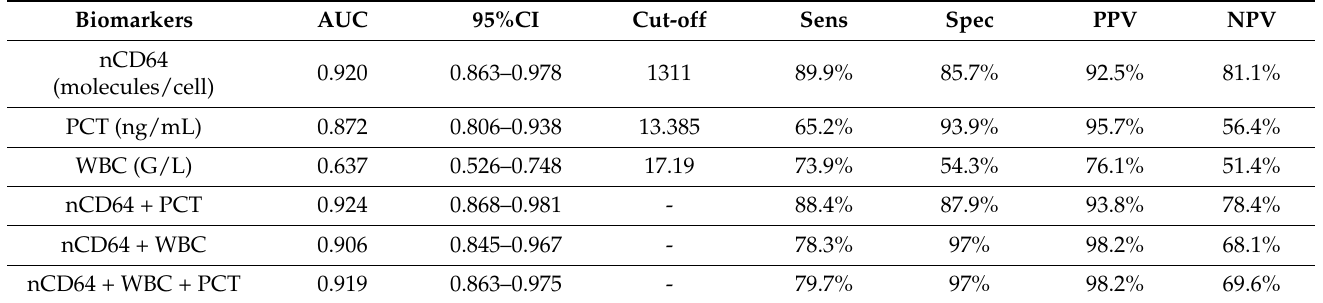
Table 3. Sepsis diagnostic values of nCD64, PCT, and WBC among 104 study participants.